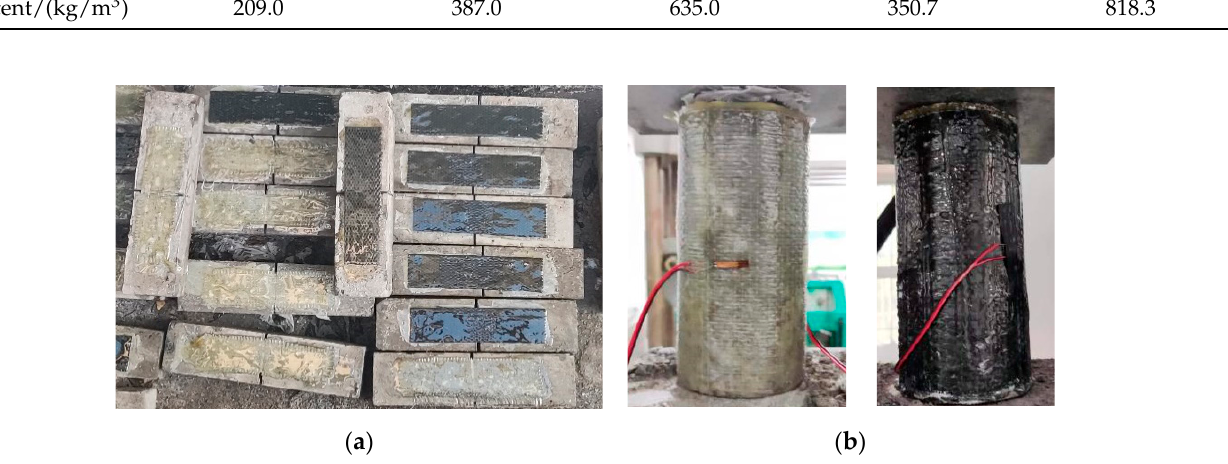
Figure 2. Specimen preparation: ( a ) FRP-reinforced prism; ( b ) FRP-reinforced cylinder.